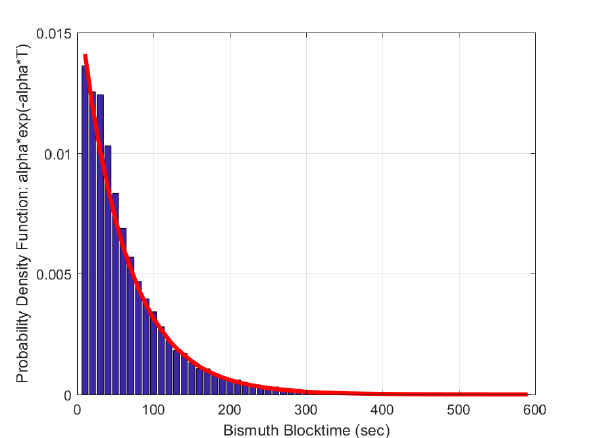
Figure 2: Theoretical probability density function (red) for the Bismuth blocktime compared against data in blocks 675,000-700,000